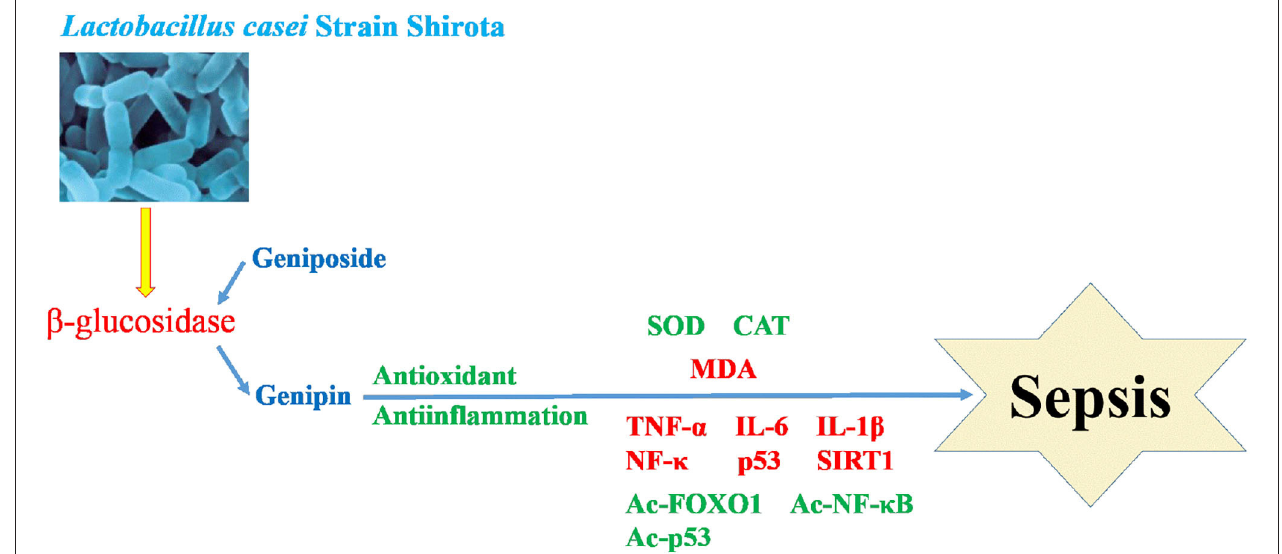
FIGURE 9 | Mechanism of LcS promoting geniposide intervention in